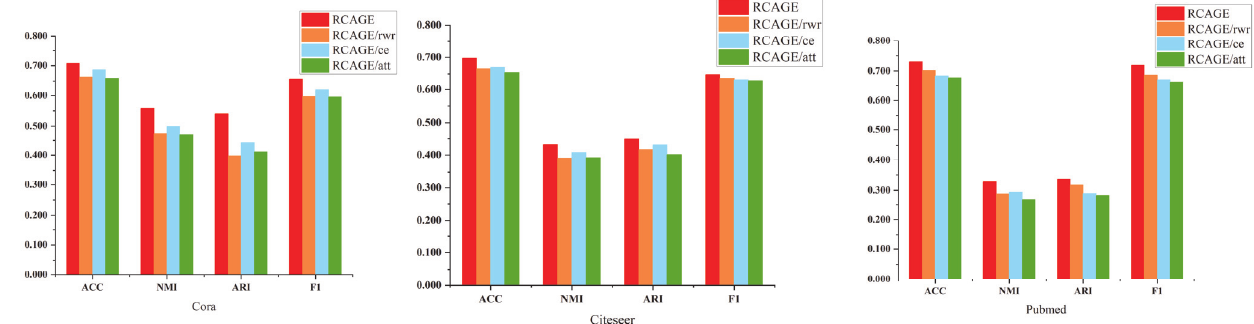
Figure 2. Comparison of different variants of the model with our method.